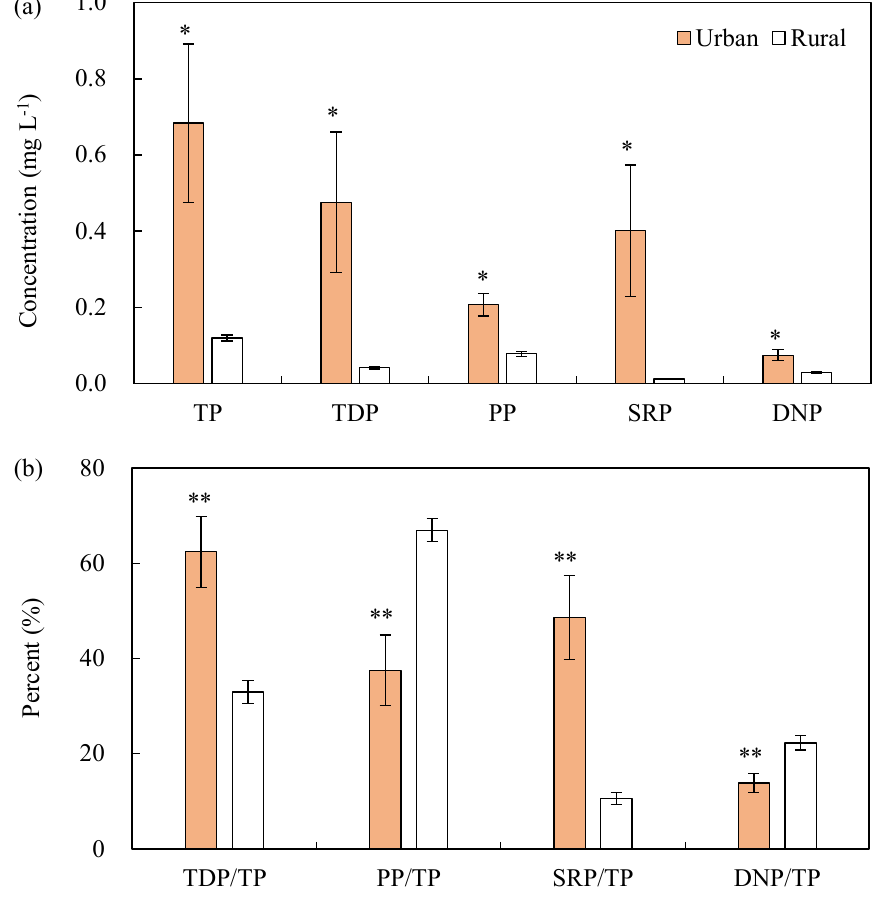
Figure 3. Concentrations of TP, TDP, PP, SRP, and DNP ( a ); and percentages of TDP/TP, PP/TP, SRP/TP, and DNP/TP ( b ) in rural and urban rivers. TP = total phosphorus; TDP = total dissolved phosphorus; PP = particulate phosphorus; SRP = soluble reactive phosphorus; DNP = dissolved nonreactive phosphorus. * ( p < 0.05) and ** ( p < 0.01) indicate significant differences between the rural and urban rivers ( t